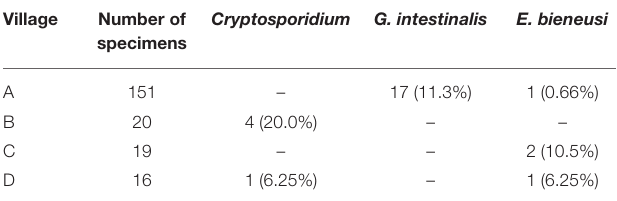
TABLE 2 | Distribution of positive samples in different villages. Cryptosporidium G. intestinalis Village Number of specimens